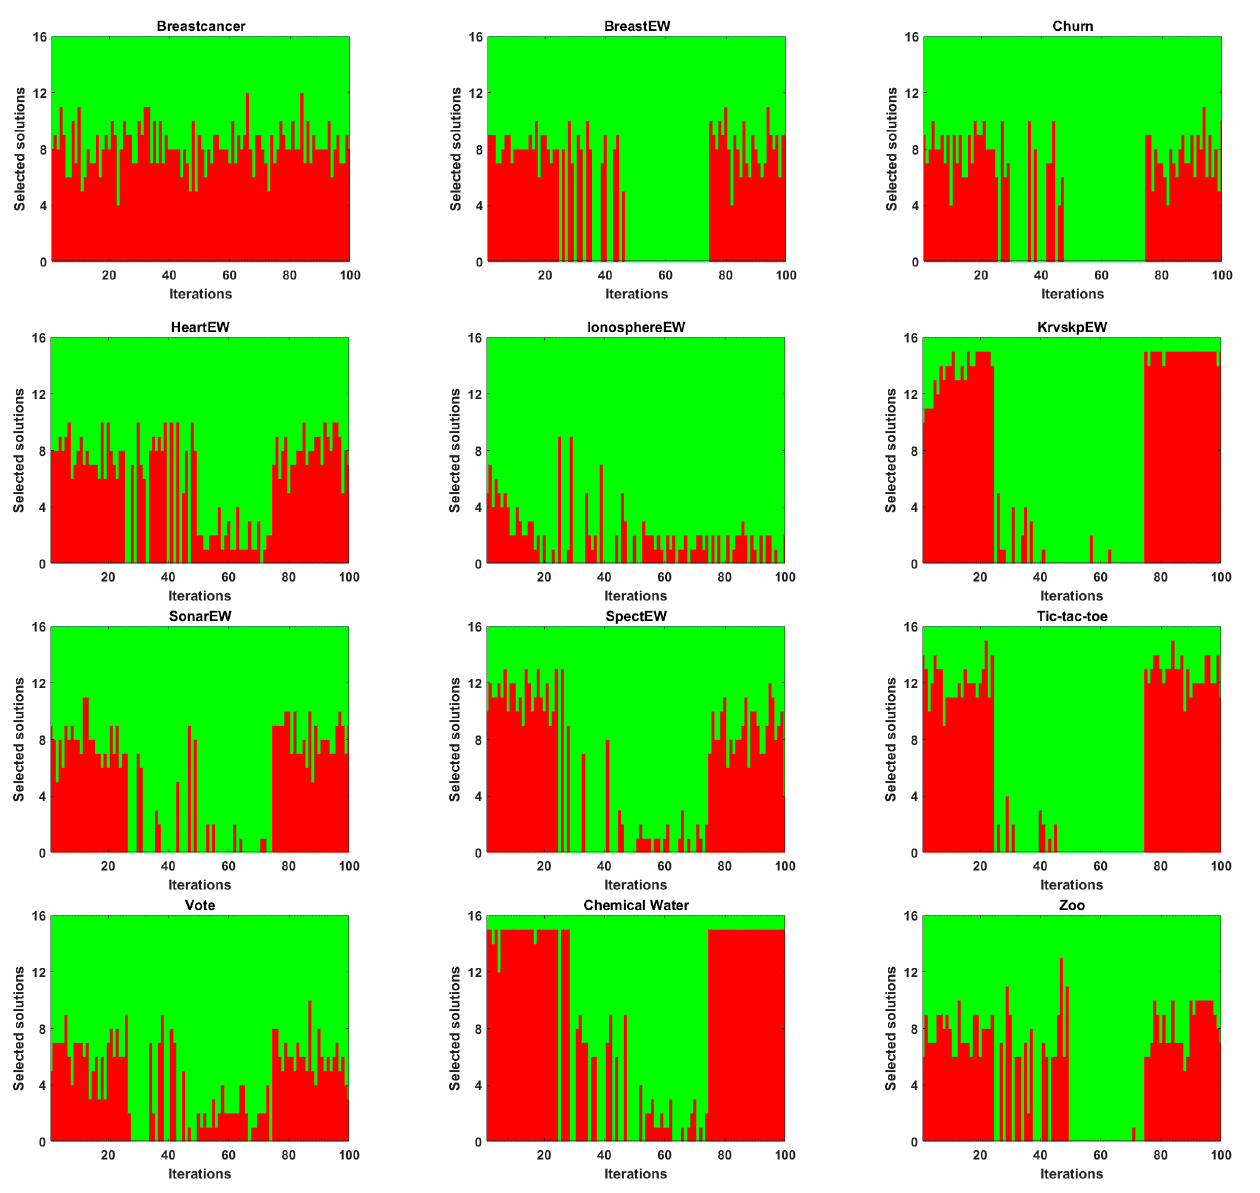
Figure 3. Distribution of best selected candidate solutions between RSA and SO for different da ‐